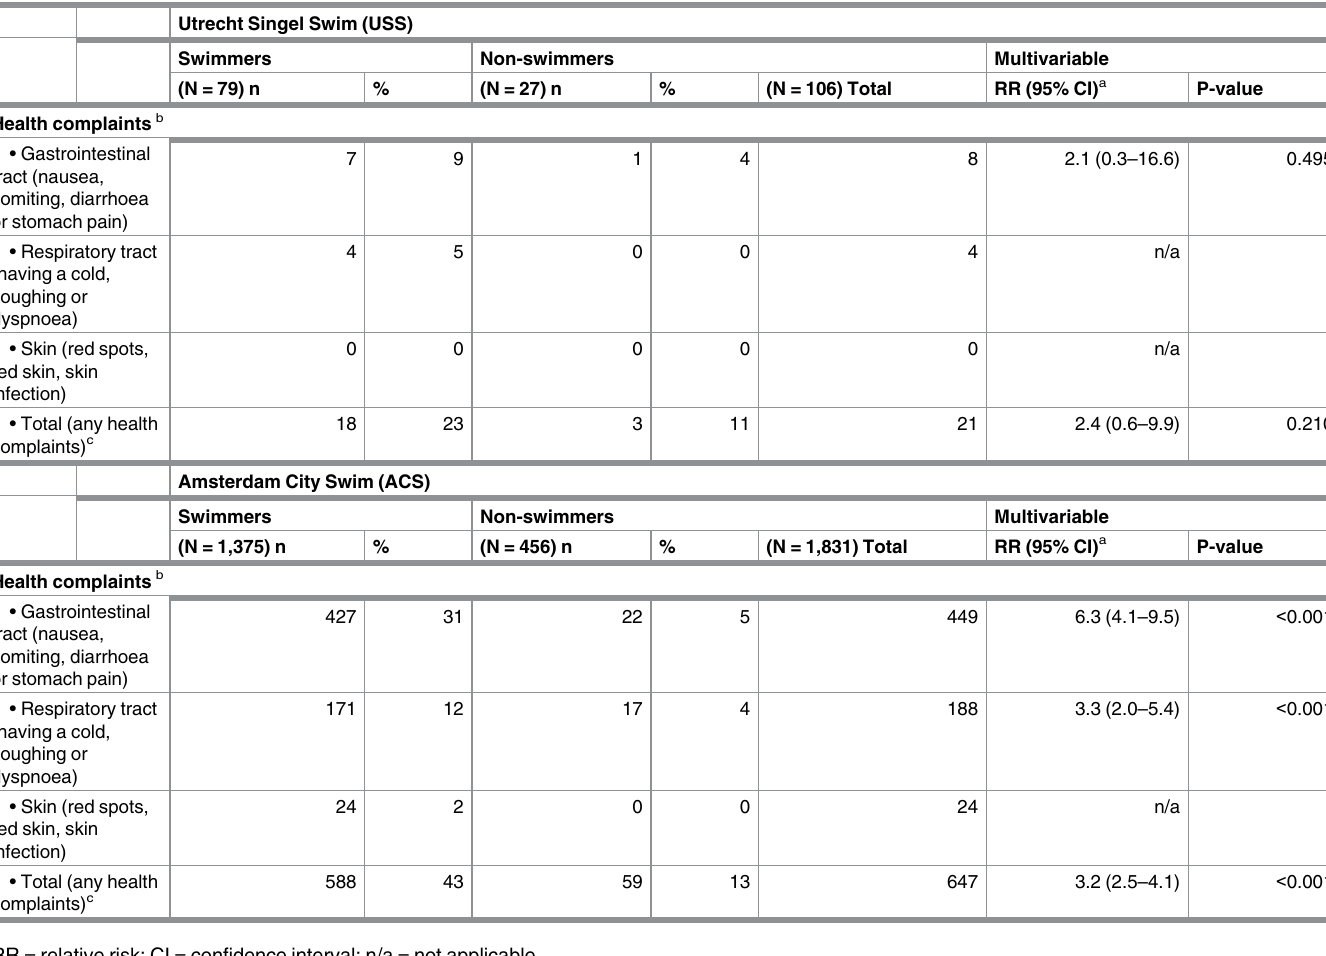
Table 1. Reported health complaints, risk ratios and 95% confidence intervals following the Utrecht Singel Swim and AmsterdamCity Swim, 14 June 2015 and 6 September 2015. Utrecht Singel Swim